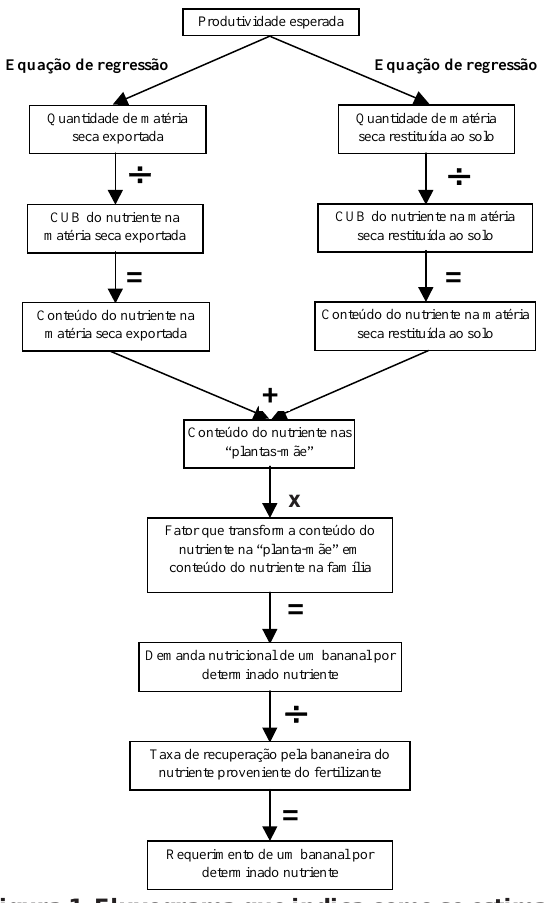
Figura 1. Fluxograma que indica como se estima o requerimento de um bananal por um nutriente no primeiro ciclo de produção, no qual se conduz, em cada touceira, uma “família” (mãe- filha-neta) de